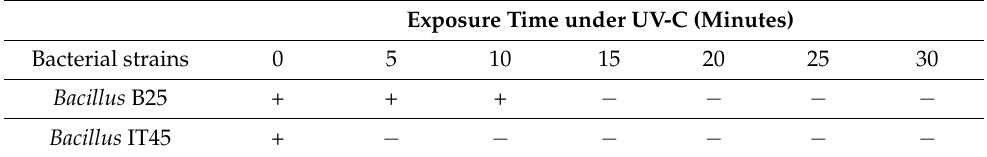
Table 7. Sensitivity of Bacillus strains to UV-C.